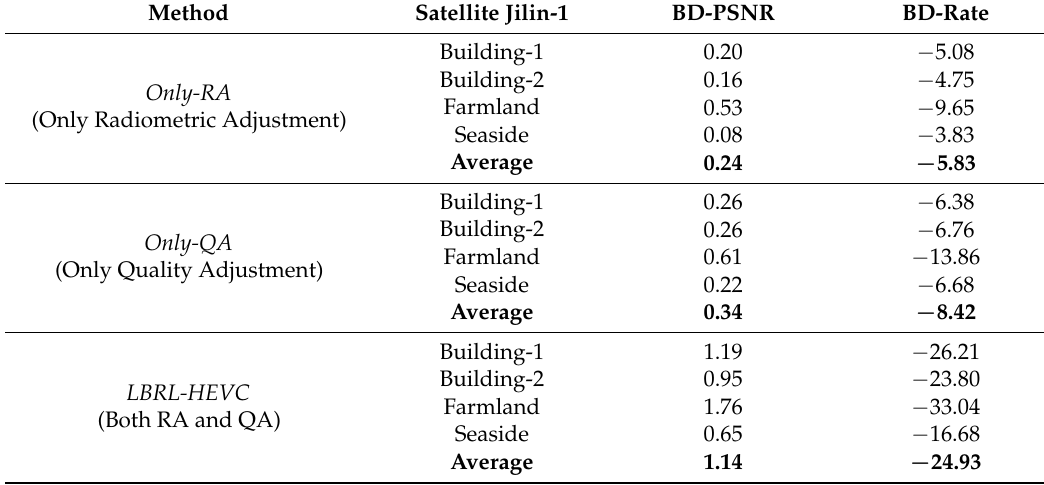
Table 3. The overall BD-PSNR (dB) and BD-Rate (%) of Only-RA , Only-QA , and LBLR-HEVC vs. HEVC with satellite